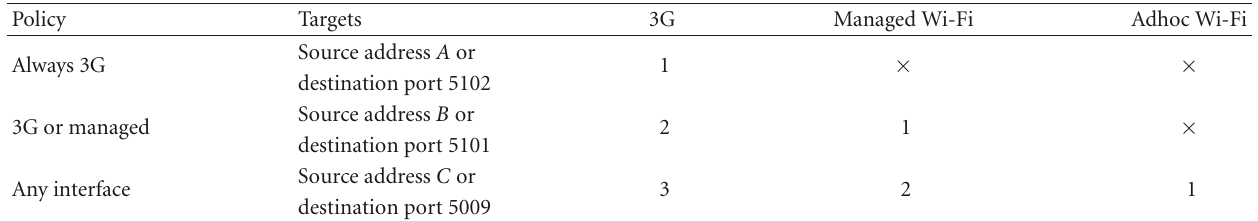
Table 4: Flow distribution policies for MR1. Smaller numbers reflect higher